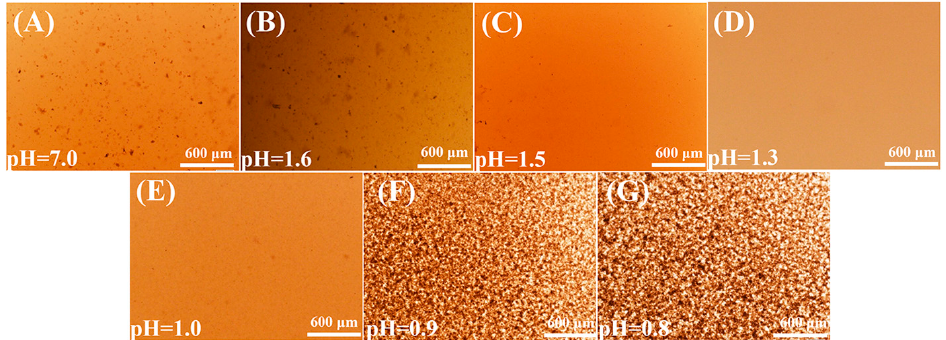
Figure 7. Optical microscope images of GO@Fe 3 O 4 sol under various pH conditions ( A ) pH = 7.0; ( B ) pH = 1.6; ( C ) pH = 1.5; ( D ) pH = 1.3; ( E ) pH = 1.0; ( F ) pH = 0.9; ( G ) pH = 0.8.